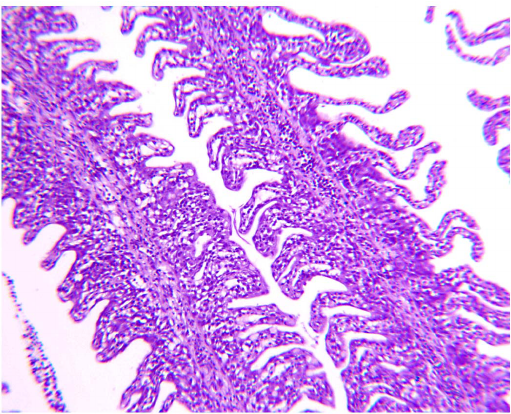
Figure 1. Gill histopathology observed epithelial hyperplasia in rainbow trout fed Diet U without vitamin and mineral premix for 10 weeks, as compared to normally appearing gills in fish fed the supplemented Diet S. (Photos: Dr. Anne-Berit Olsen,